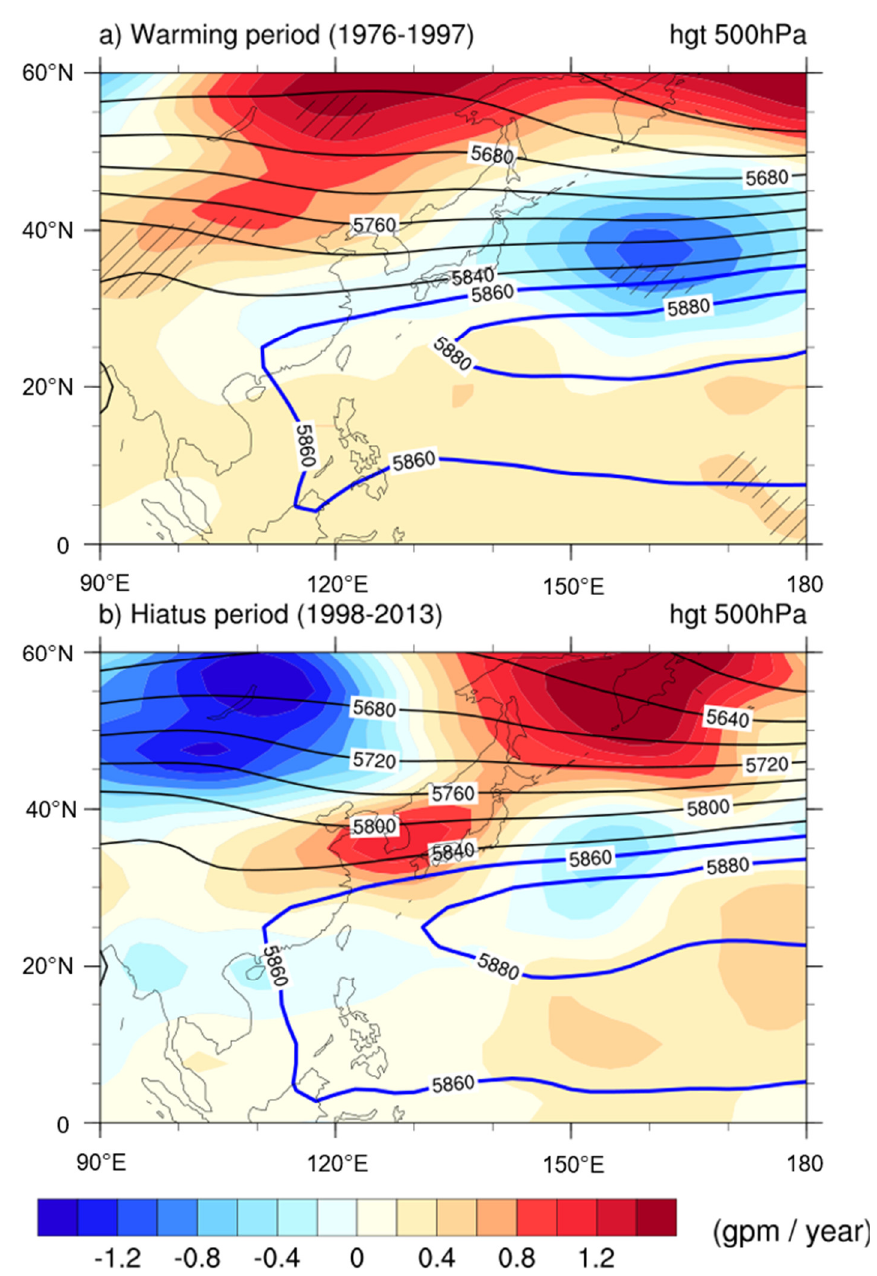
Figure 4. Same as Figure 3, but for geopotential height at 500 hPa; blue contours represent the values of 5860 and 5880 gpm.